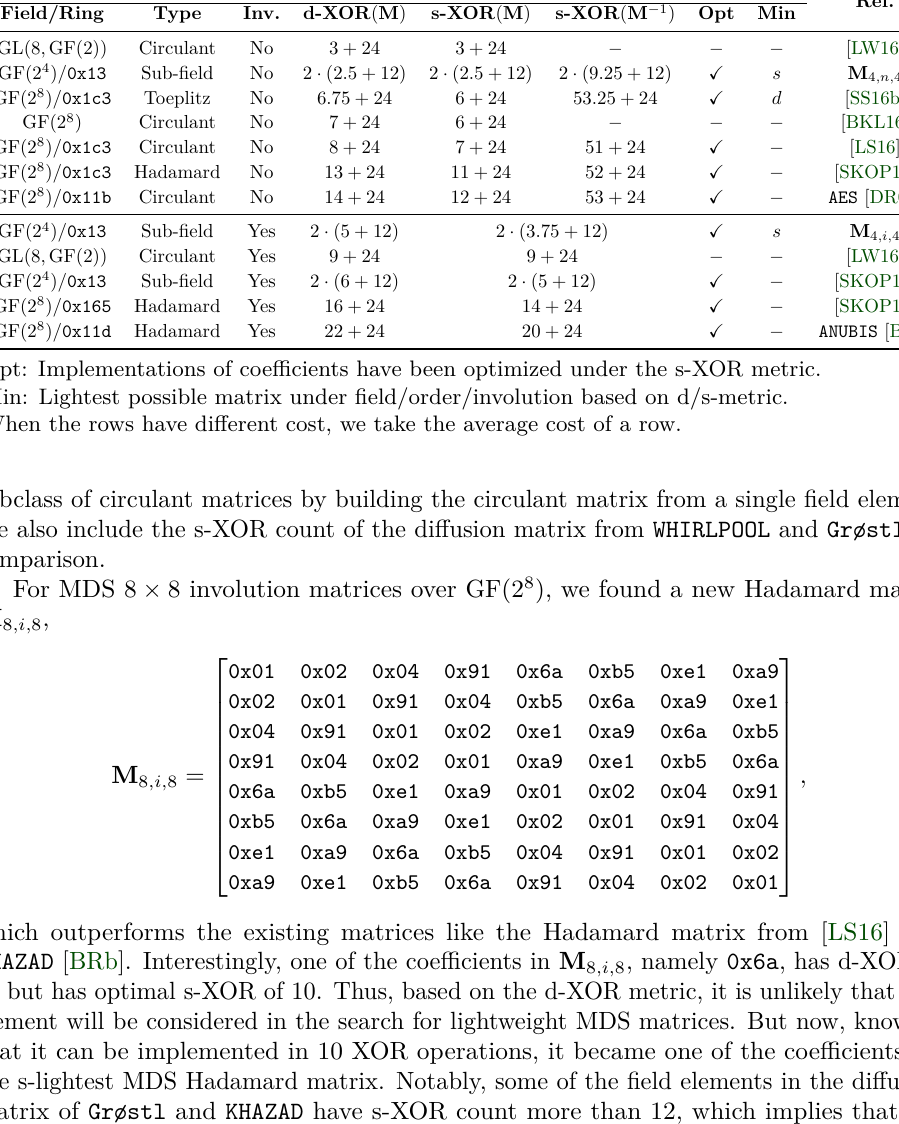
Table 5: Comparison of 4 × 4 MDS matrices over GF(2 8 ) and GL(8 , GF(2)).